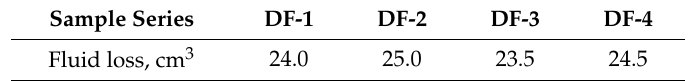
Table 6. The leakage rate of the liquid phase of the drilling fluid mixture series (DF) over 30